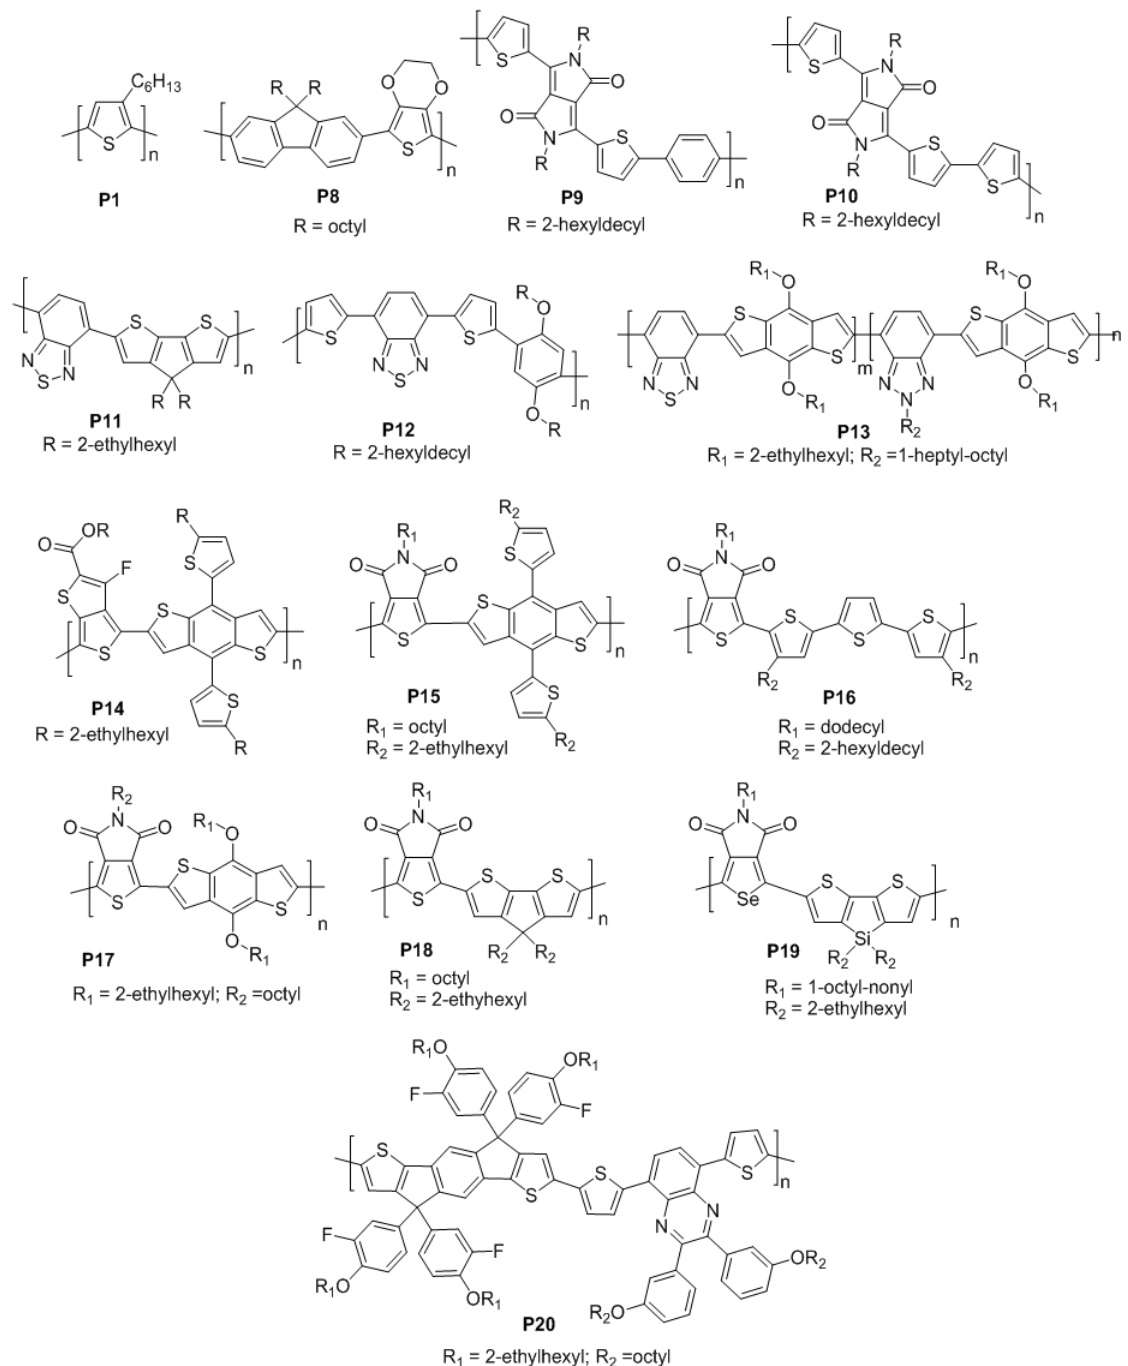
Figure 5. Materials made using DHAP and conventional methods, evaluated in organic photovoltaic (OPV)